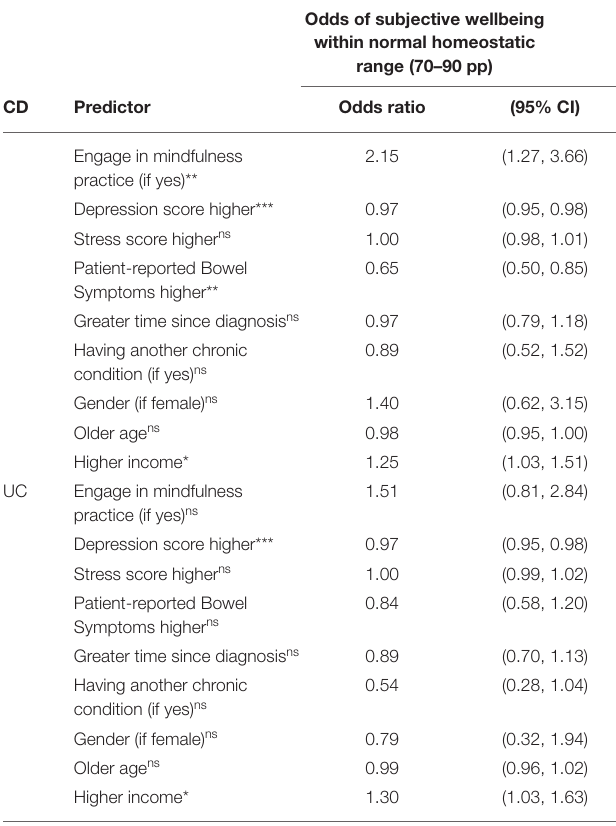
TABLE 4 | Predictors of subjective wellbeing in the normal homeostasis range for people with CD or UC. Odds of subjective wellbeing within normal